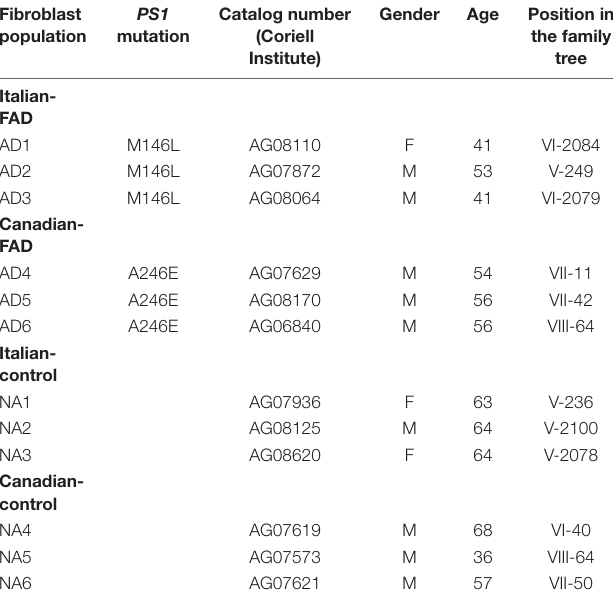
TABLE 1 | Characteristics of the fibroblast cell lines of individuals with familial AD (FAD- PS1 ) and control